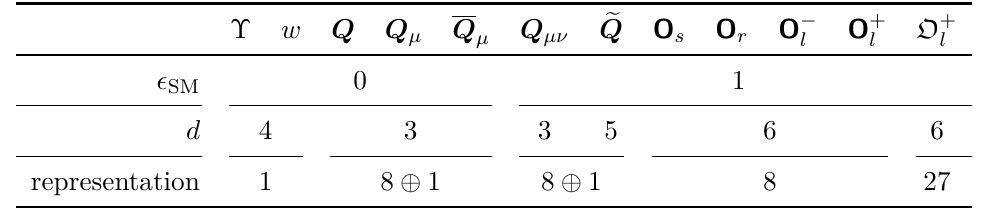
Table 1. Colour singlets and quark multilinears at the strong scale. For each of them, we show respectively their order in (cid:15) , their mass dimension d and their flavour representation. The SM composite gluon operators Υ and w are defined in Lagrangians (2.4) and (2.10), the quark bilinears Q are defined in (2.8), (2.21), and (2.29), and the quark quadrilinears O and O are defined in (2.51), (2.57), and (2.58). The corresponding external currents including their SM and BSM contribution are listed in table